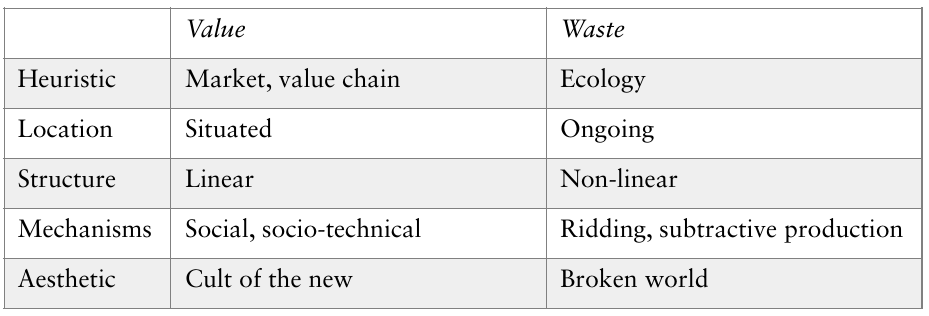
Table 1. Value and waste paradigms for understanding